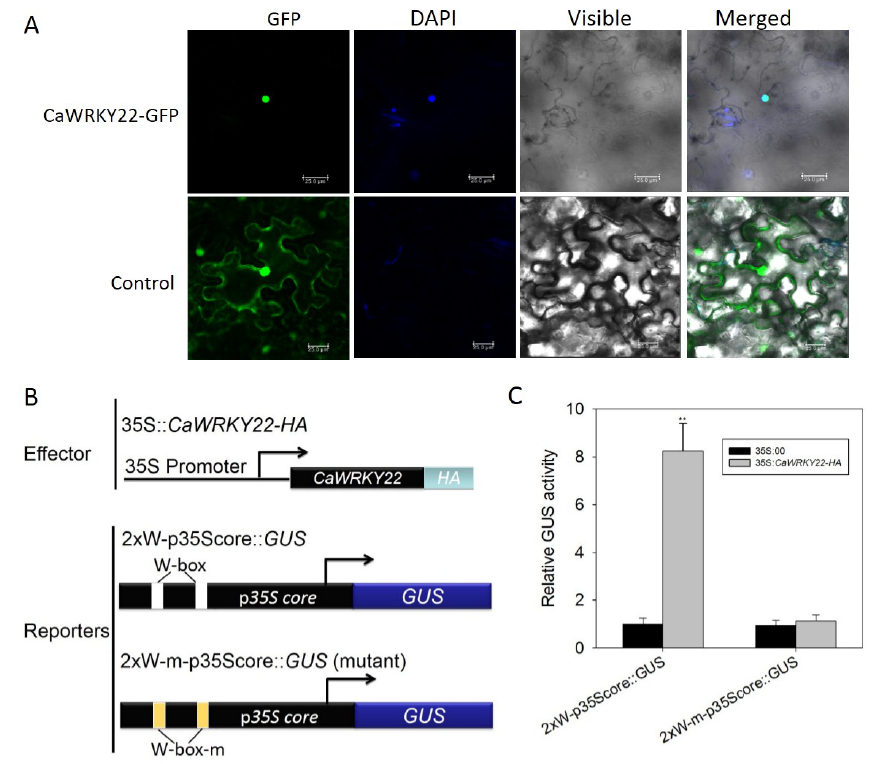
Figure 3. Subcellular localization of CaWRKY22 and its transactivation confirmation experiment. ( A ) CaWRKY22 was exclusively found in the nucleus of N. benthamiana leaves, the transiently expressed 35S: CaWRKY22 –GFP. Green color shows GFP. Blue color shows DAPI staining of nucleus. Cyan clor shows merger of green GFP and DAPI stained nucleus. GFP signal (Green) for the control N. benthamiana leaves was found throughout the cell. Images were taken by confocal microscopy at 48 hpi (hours post inoculation). Bars = 25 µm; ( B ) schematic diagram of the effector and reporter constructs used for transient coexpression; ( C ) leaves of pepper were cotransfected with the reporter